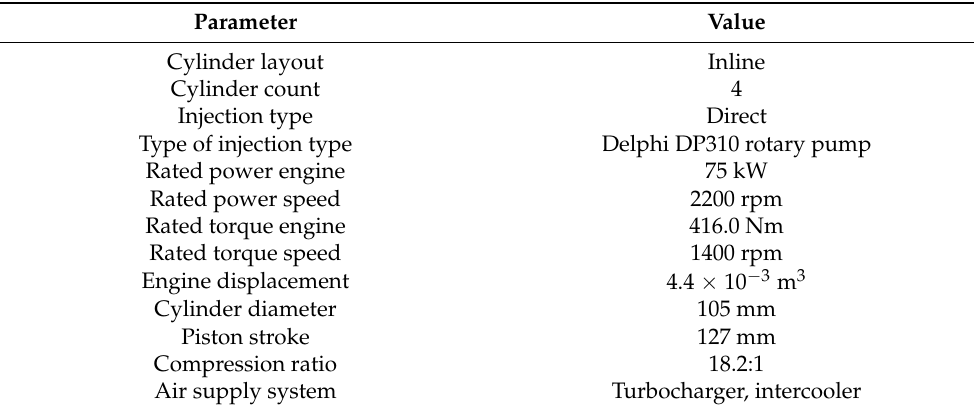
Table 1. Basic technical data of the